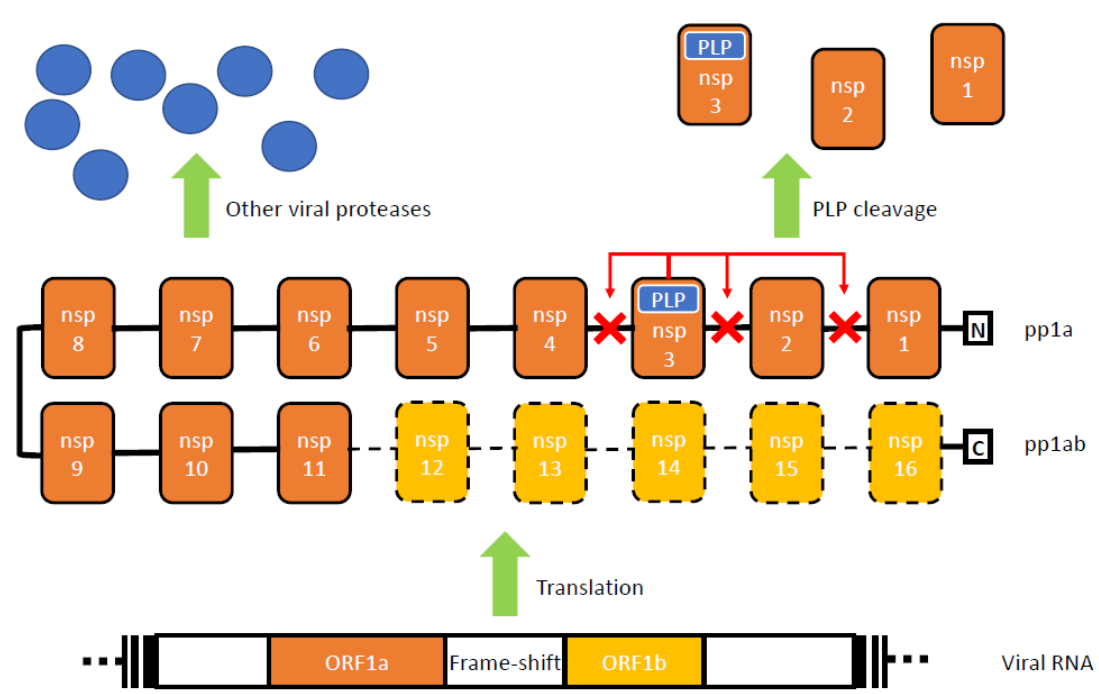
Figure 1. Schematic representation of the role of severe acute respiratory syndrome (SARS)-coronavirus (CoV) papain-like protease (PLP) role during infection. The figure represents the early roles of SARS-CoV PLP during the replication phase. The replicase / transcription complex (RTC), is coded by two open reading frames, ORF1a and ORF1b, that, with a ribosomal frame-shift mechanism, allow for the translation of two polyproteins (pps): pp1a and pp1ab. Pps are in turn constituted by 16 non-structural proteins (nsp), 1-11 for pp1a and 1-16 for pp1ab. SARS-Cov PLP is encoded within nsp3 and is responsible for the cleavage of the N-terminal portion of pps, cutting the bonds between nsp1 / 2, nsp2 / 3 and nsp3 / 4.